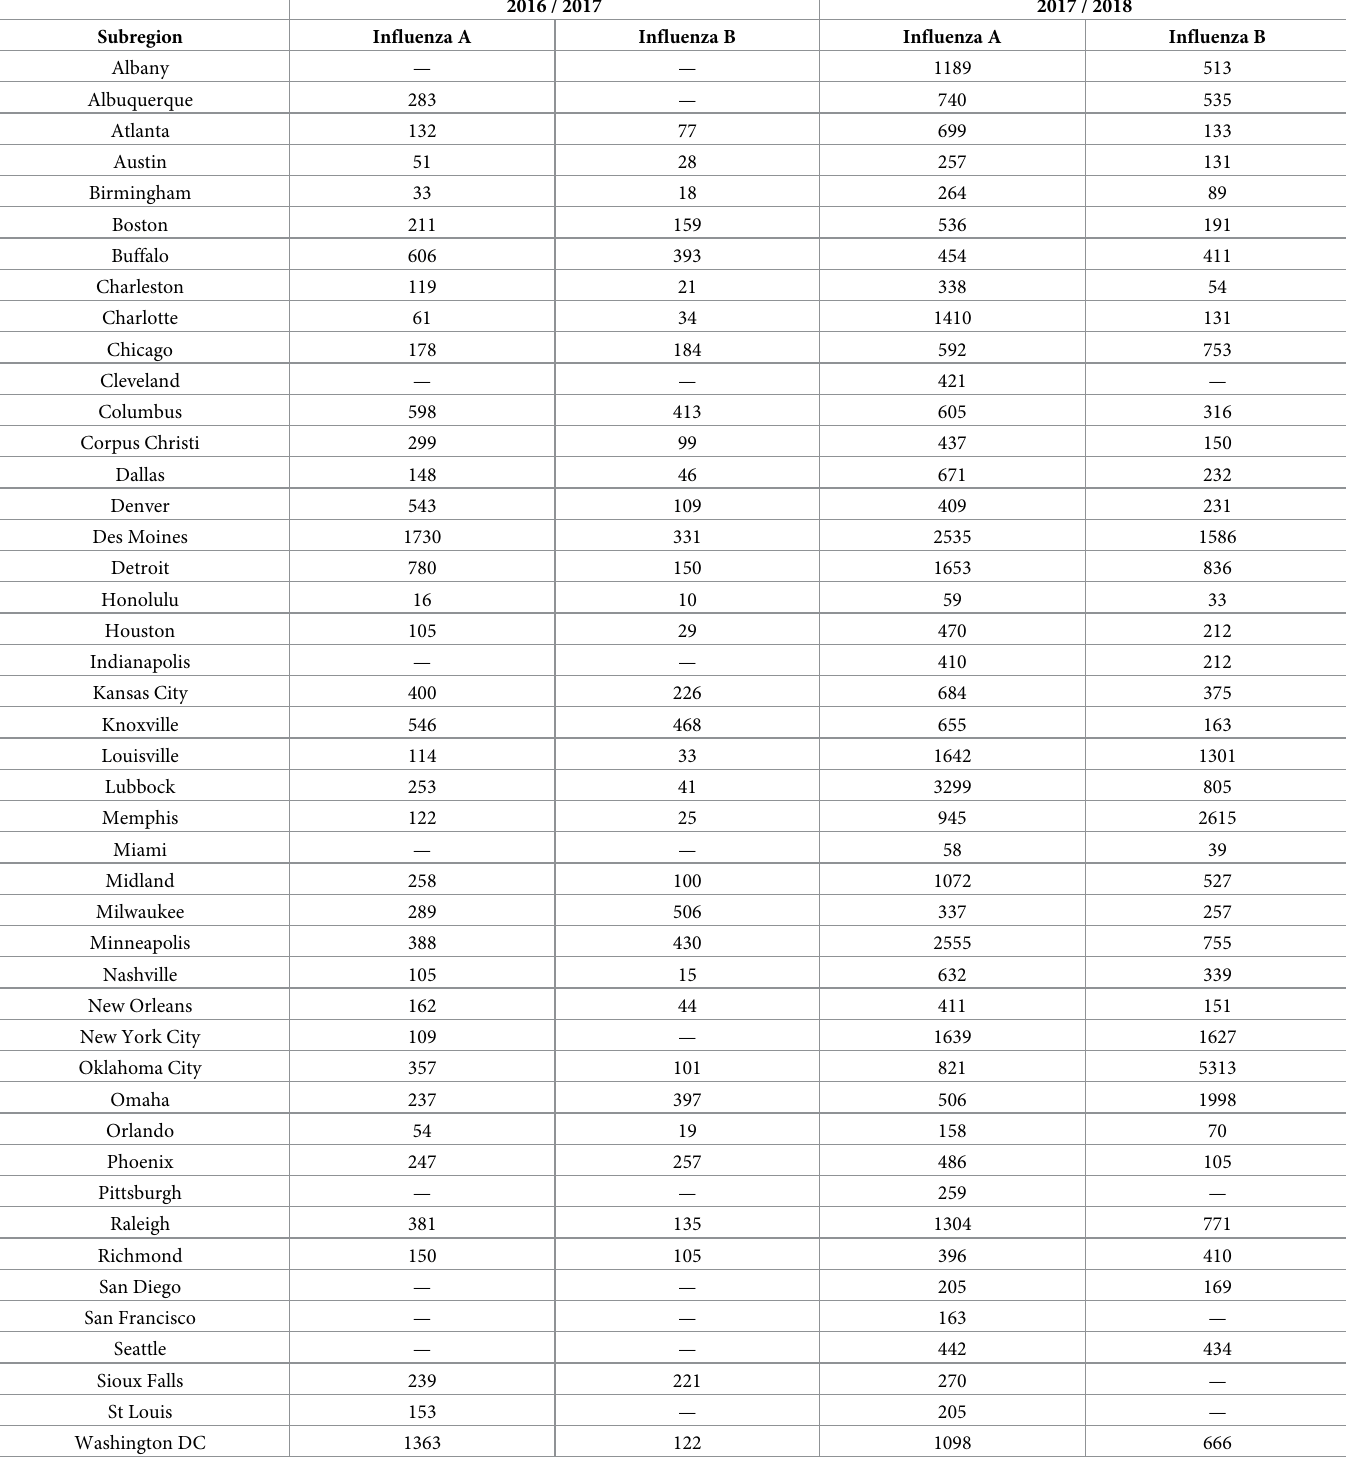
Table 2. Cross-seasonal ratios for each subregion by year and influenza type. For more detailed results see the S1